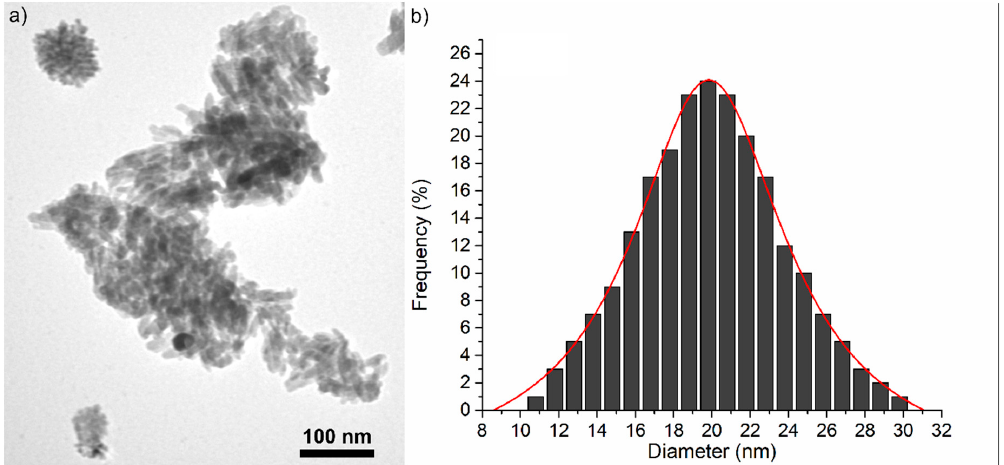
Figure 9. Representative image of ZnHApD powders ( a ) and size distributions ( b ) obtained by transmission electron microscopy (TEM). Scale bars = 100 nm.